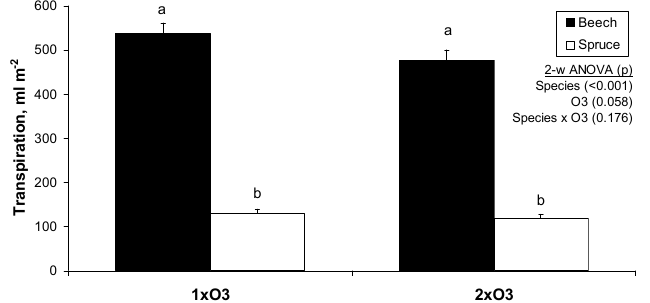
Figure 3. Mean daily total transpiration ( ± SE) calculated from sap flow measurements in beech and spruce trees. Each bar is the average of 4–5 trees in 31 days (July 2007). The inset shows the levels of significance from a two-way (tree species x O 3 regime) analysis of variance ( n = 31 days).